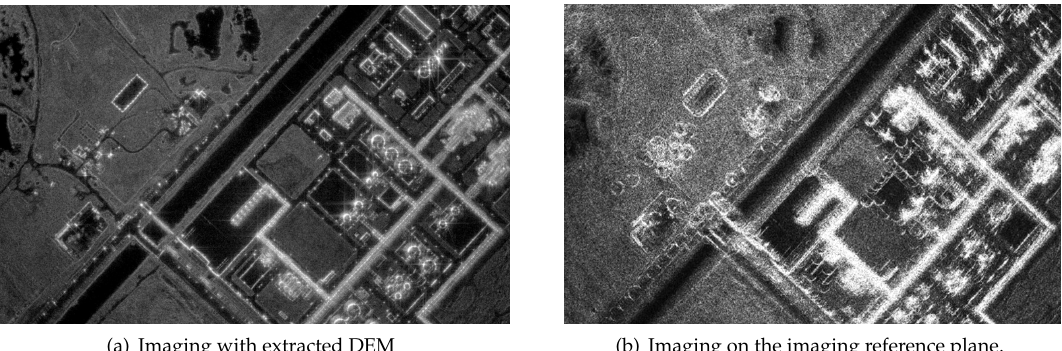
Figure 17. All-aperture image formed via magnitude accumulation of all the sub-aperture images.